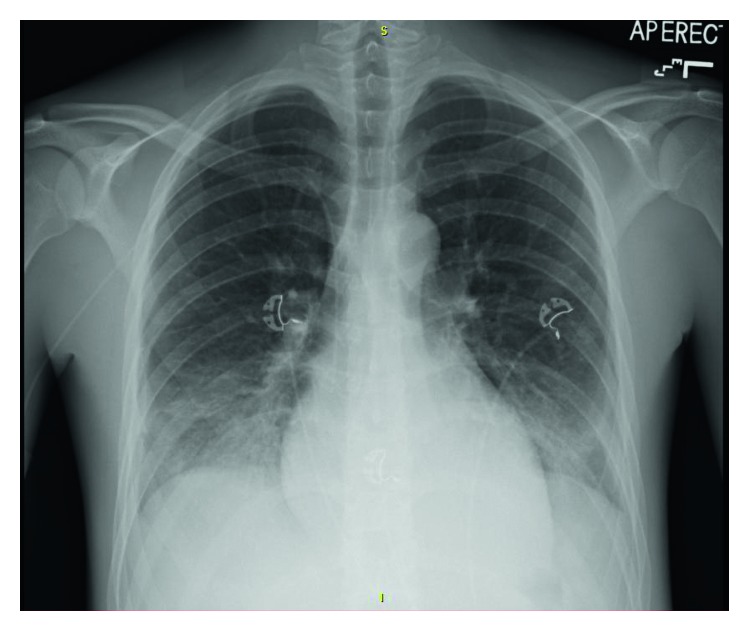
Bibasilar opacities.